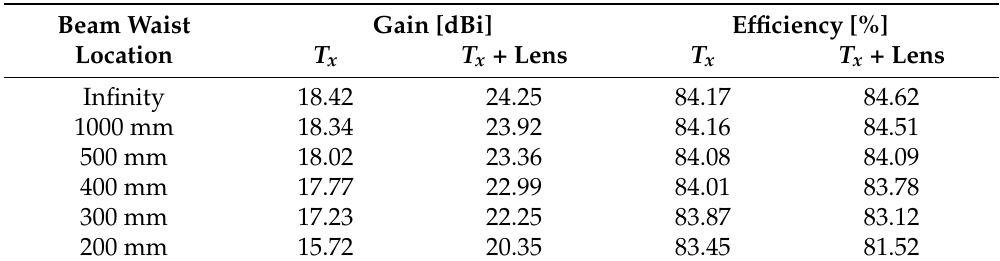
Figure 12. Comparison of the phased array antenna and lens’ electric field distribution ( a ) and far field gain ( b ), for a focus at infinity and located at 200 mm from the antenna. Table 3. Far-field simulation results of just the phased-array ( T x ) and phased-array and lens radiating system ( T x +